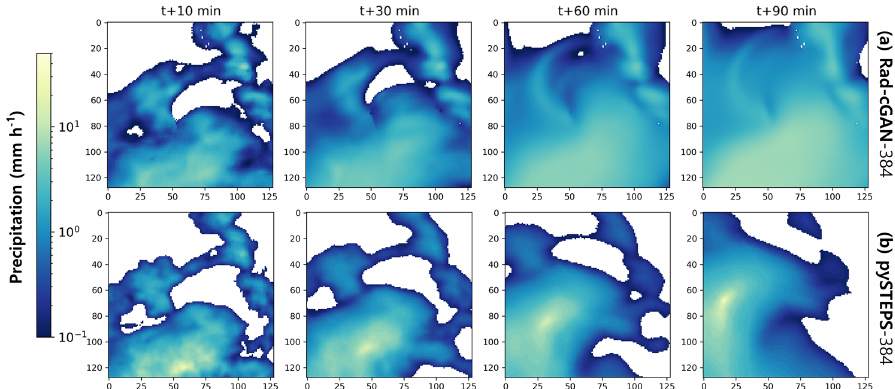
Figure 7. Example of precipitation at forecasting time t = 23 August 2018, 17:50UTC, for model predictions using increased input area (384 × 384). Panels from top to bottom express (a) prediction of Rad-cGAN, and (b) prediction of pySTEPS.